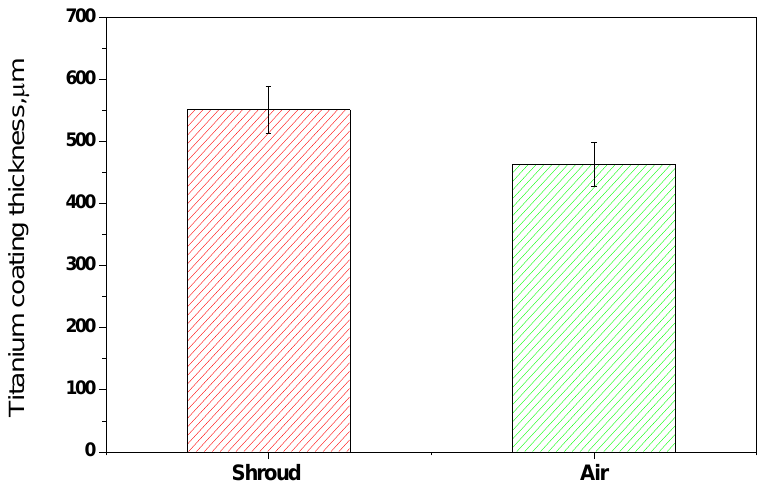
Figure 6. The thicknesses of plasma-sprayed Ti coatings with/without the shroud. The error bars represent the standard deviation.